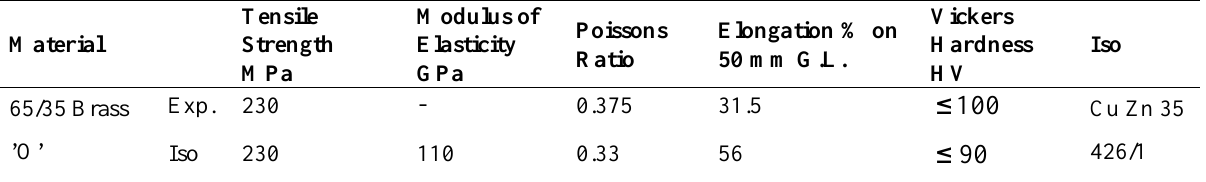
Mechanical properties for Brass sheet (Iso- Cu Zn 65-35 426/1). Material